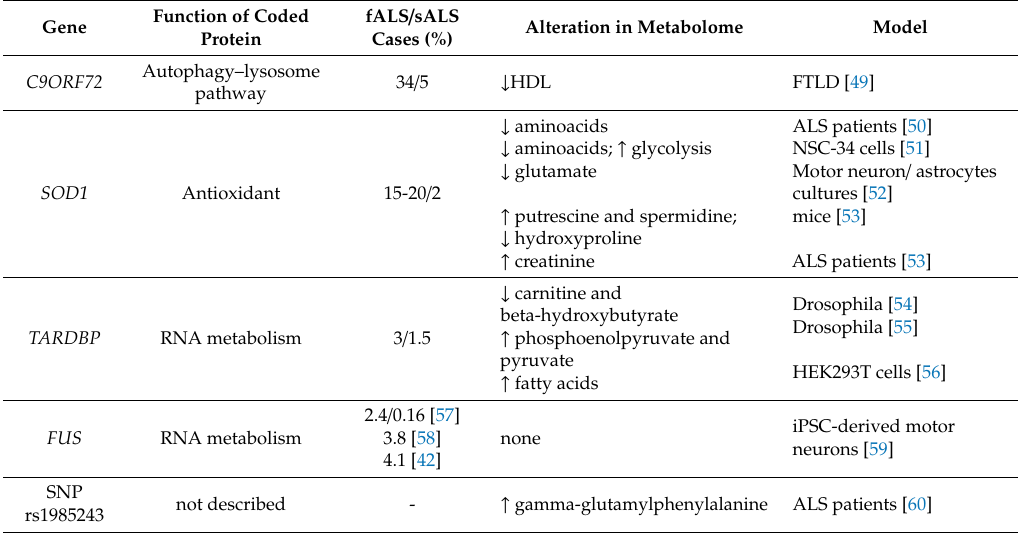
Table 1. Metabolomics findings from studies performed in genes associated with amyotrophic lateral sclerosis (ALS)